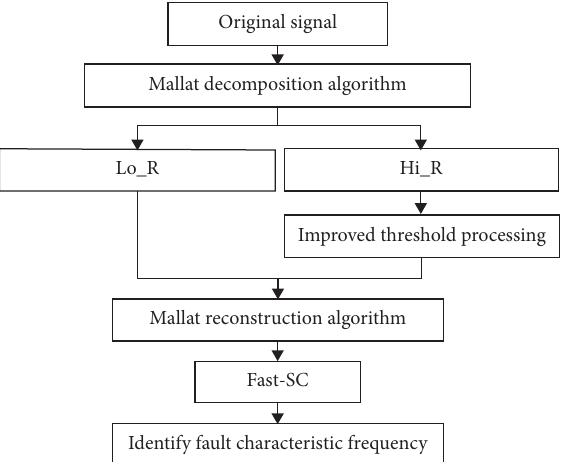
Figure 1: The flowchart of this